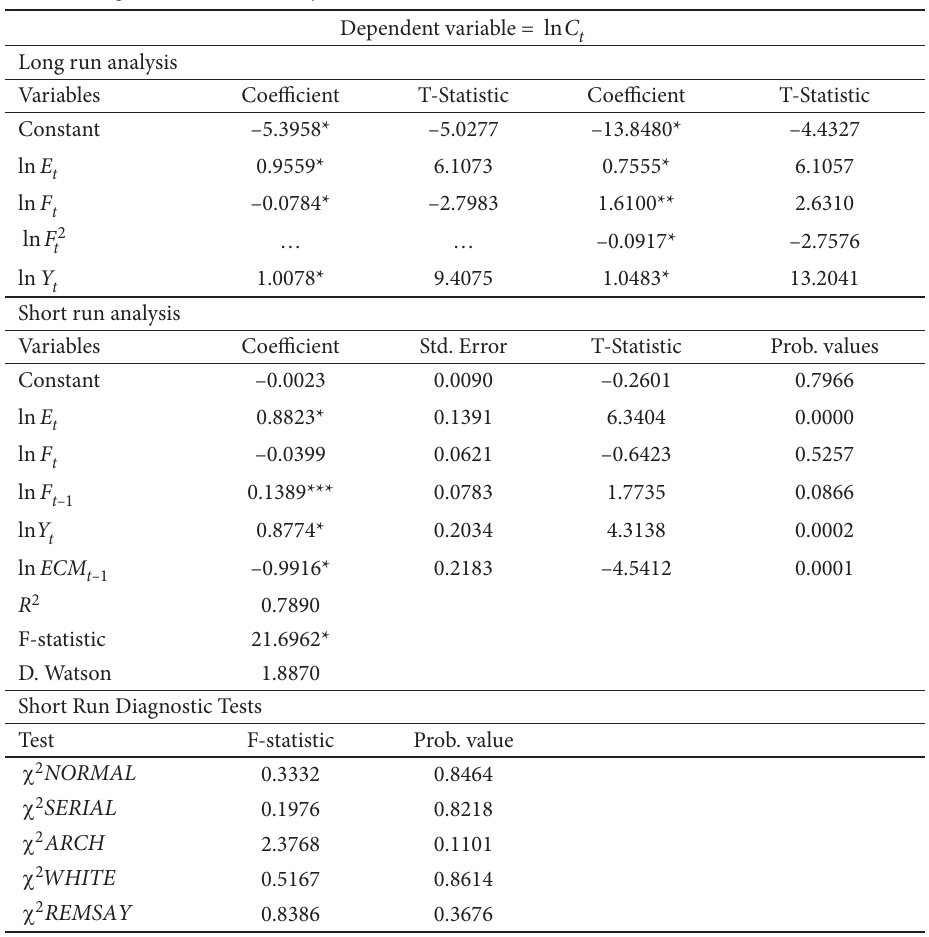
Table 4. Long-and-short runs